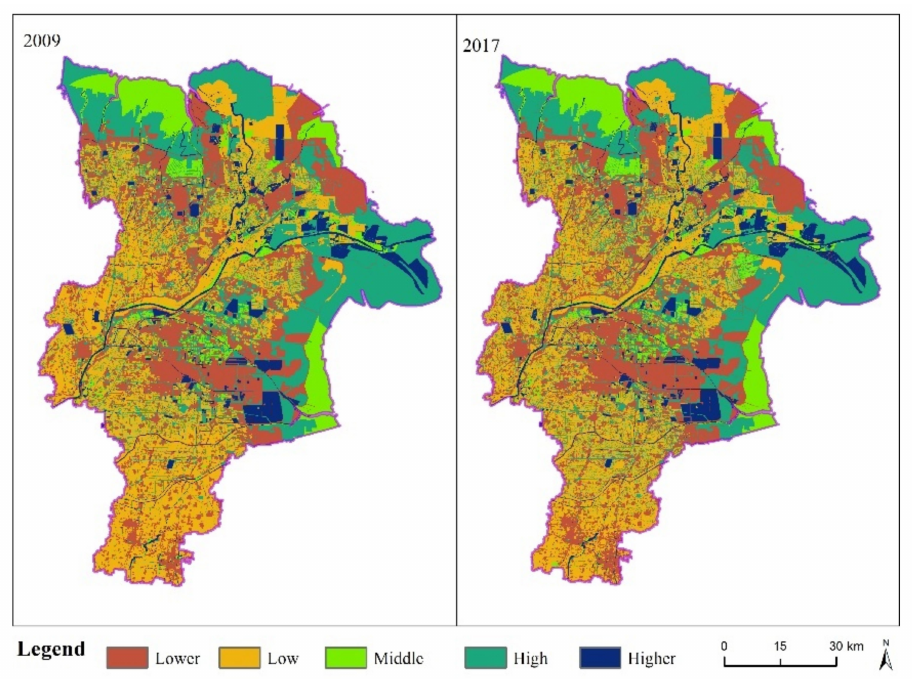
Figure 6. Spatial distribution of habitat quality in Dongying City in 2009 and